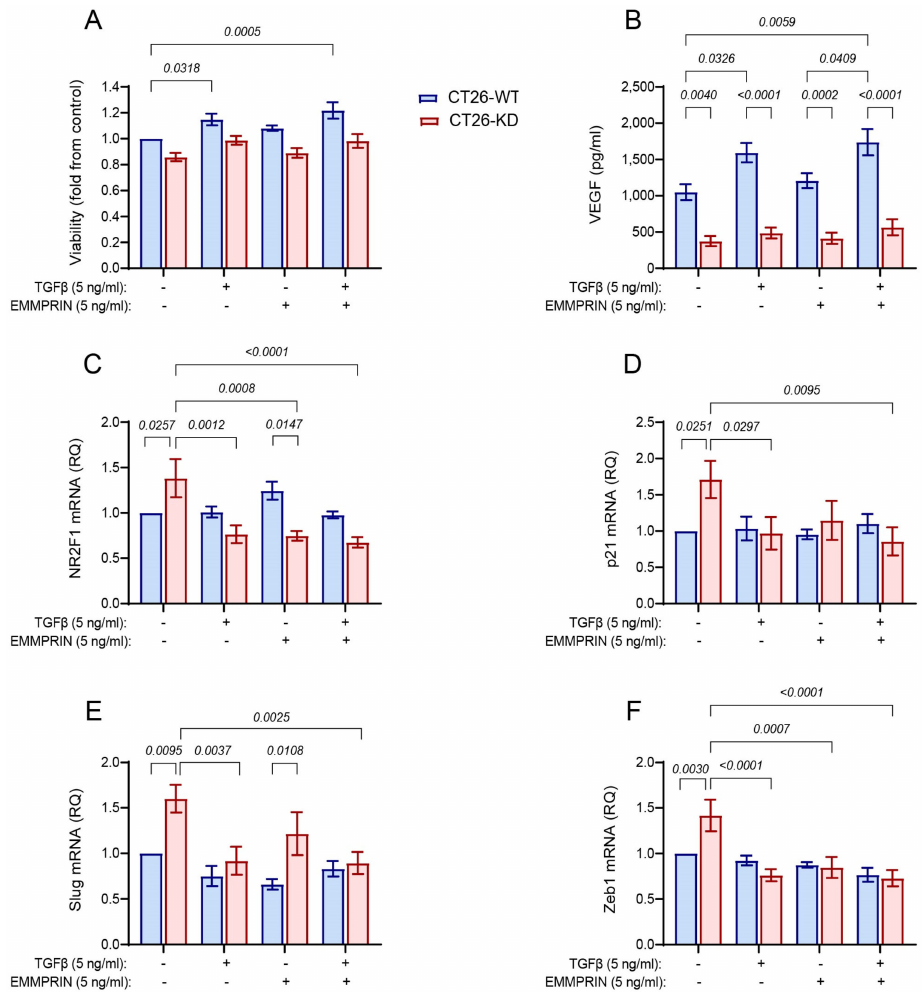
Figure 7. The combination of recombinant TGF β and EMMPRIN has no effect on the addition of TGF β or EMMPRIN alone. CT26-WT or CT26-KD cells (2.5 × 10 4 cells) were incubated in triplicates for 48 h in serum starvation medium, with or without the addition of recombinant TGF β (5 ng/mL), EMMPRIN (5 ng/mL), or their combination. The effect on the ( A ) proliferation, as measured by CCK8 ( n = 10), ( B ) the concentrations of secreted VEGF ( n = 5), as well as the mRNA expression of ( C ) NR2F1 ( n = 6), ( D ) p21 ( n = 6), ( E ) Slug ( n = 6), and ( F ) Zeb1 ( n = 6). Data are presented as means ±